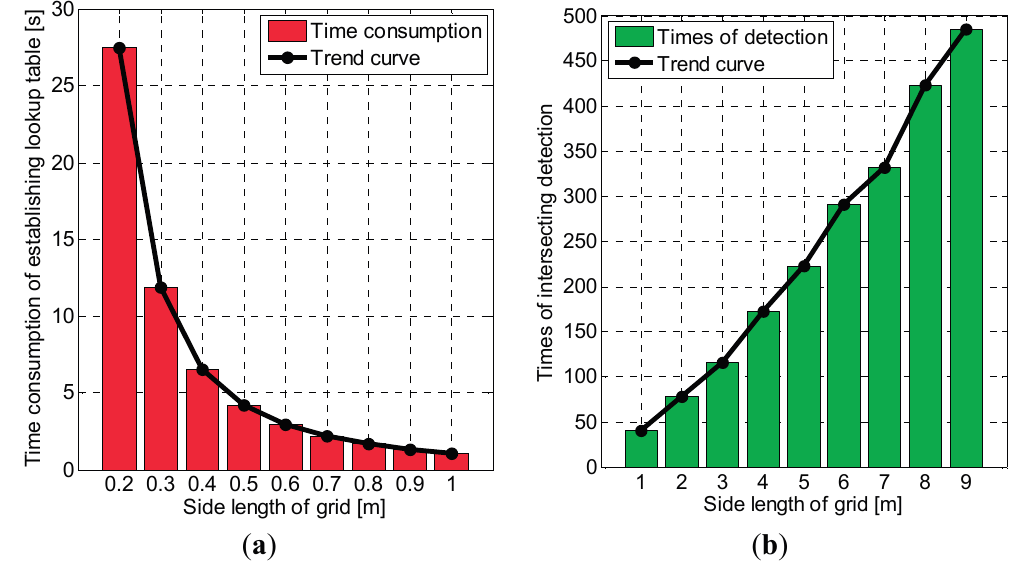
Figure 20. Illustrations of relationships between side length of grids and ( a ) time consumption of establishing the lookup table ( b ) times of intersecting detection for each particle. Black curves indicate the trend of